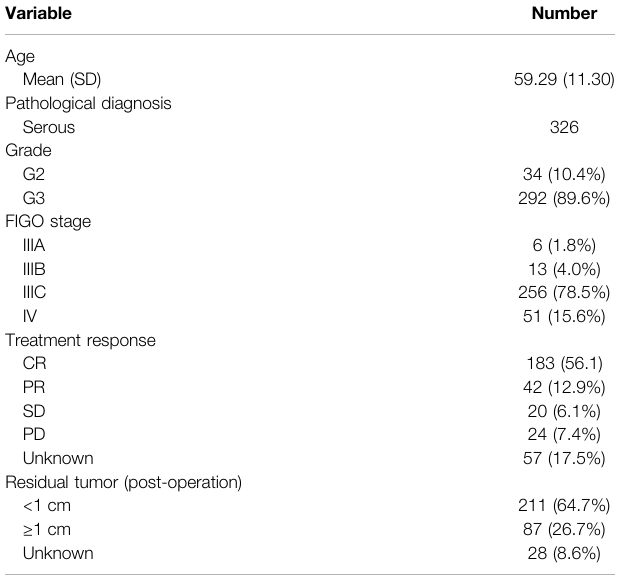
TABLE1| TheclinicalcharacteristicsoftheHGSOVcohortintheTCGAdatabase.